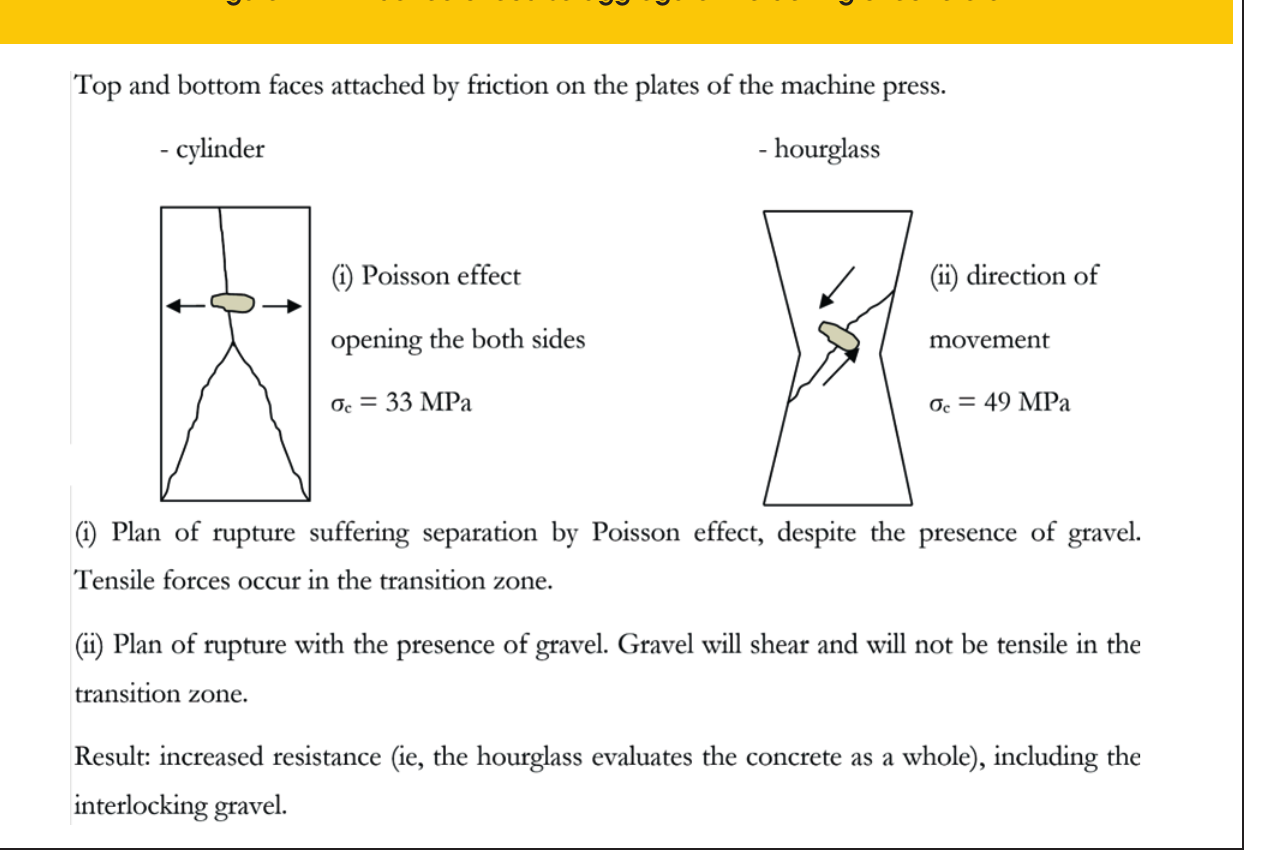
Figure 14 – Influence of course aggregate in cracking of